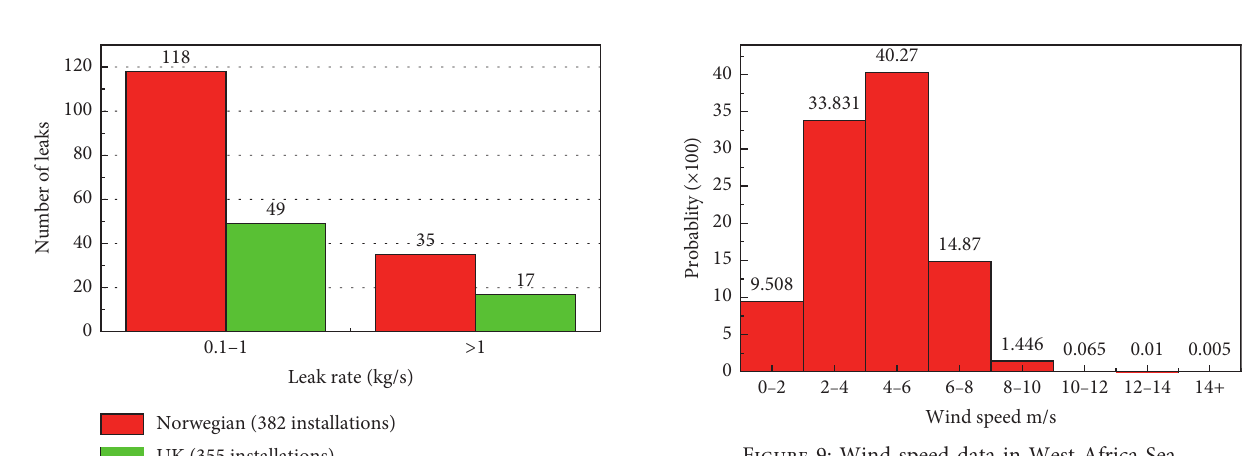
Figure 6: Leak amount data from 135 FPSOs in the UK.